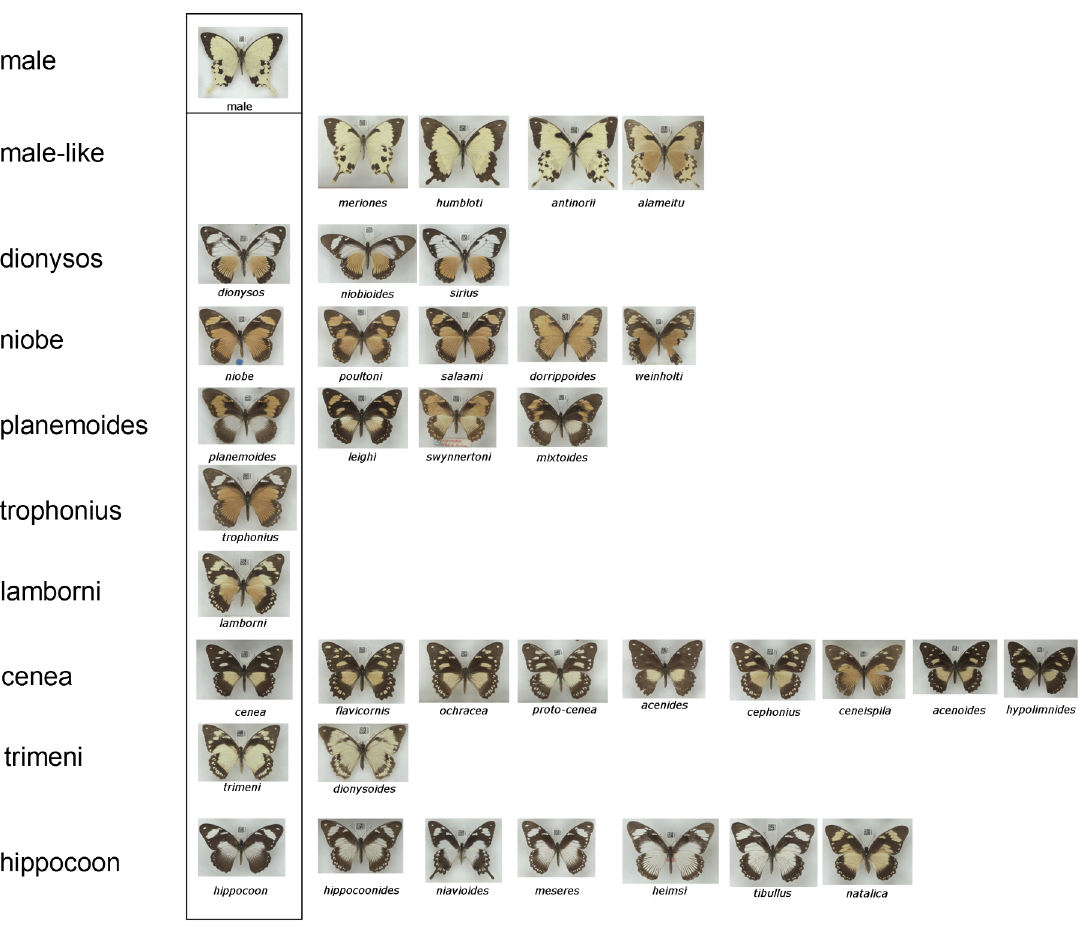
Figure 1. Female morphs of Papiliodardanus recognised in this study. Similar looking morphs are grouped into morph groups on each horizontal line, largely following the suggestions of Bernardi et al. [32]. Forms are present in order of the dominance hierarchy, apart from males and male-like forms (top two rows) and the f. dionysos group. In the case of the morph f. dionysos , no breeding work exists to support the conclusion of it being an allele at H , rather than being due to a second, unlinked locus. Not figured are forms which are not well represented in the NHM London collection, primarily some ‘tailed mimic’ forms of ssp. P. dardanus antinorii such as f. vaccaroi (tailed variant of f. cenea ).